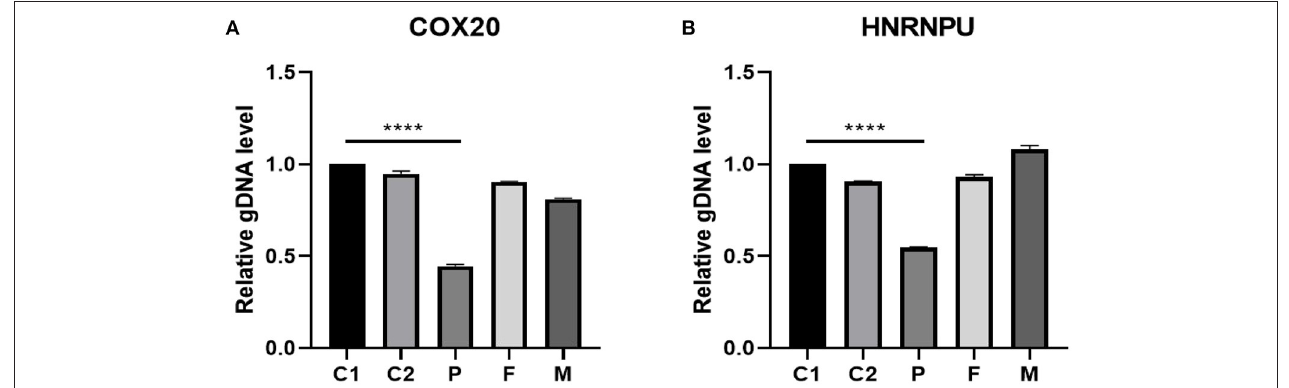
FIGURE 5 | gDNA level validated by real-time fluorescent quantitative PCR in the 1q44 region. The results suggested that the patient had a heterozygous deletion in the COX20 (A) and HNRNPU (B) genes (relative quantification ratio close to 0.5). Additionally, the parents of the patient had no deletion in COX20 and HNRNPU, suggesting that this variant was a new variant. C1 and C2 stand for controls, P stands for patient, F stands for father, and M stands for mother. Differences were considered significant at p < 0.05. **** p <